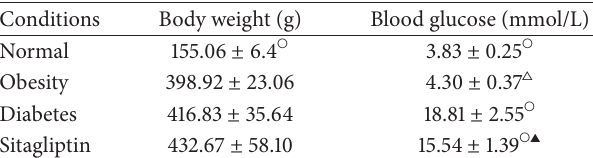
Table 1: Body weight and blood glucose changes during progression of glucose intolerance and after Sitagliptin treatment. Data are expressed as mean ± SD (compared with group obesity: I 𝑃 < 0.01 ; compared with group diabetes: 󳵻 𝑃 < 0.01 , 󳵳 𝑃 < 0.05